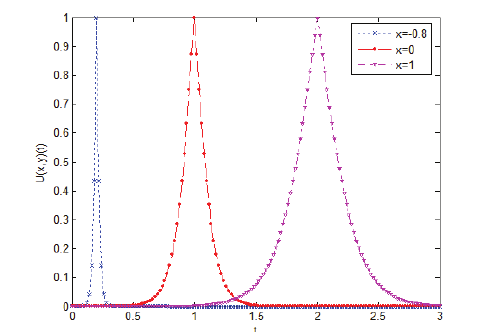
Fig. 2. The curve of fuzzy solution U ( x , y ) at different val- ues of ( x , y ) .